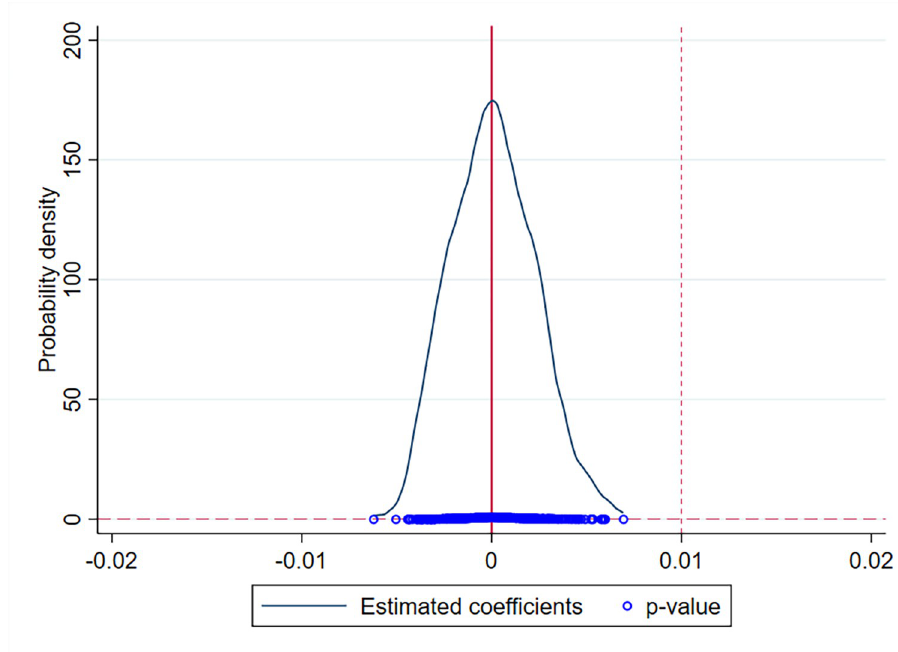
Fig 4. Distributions of estimated coefficients and p values based on placebo